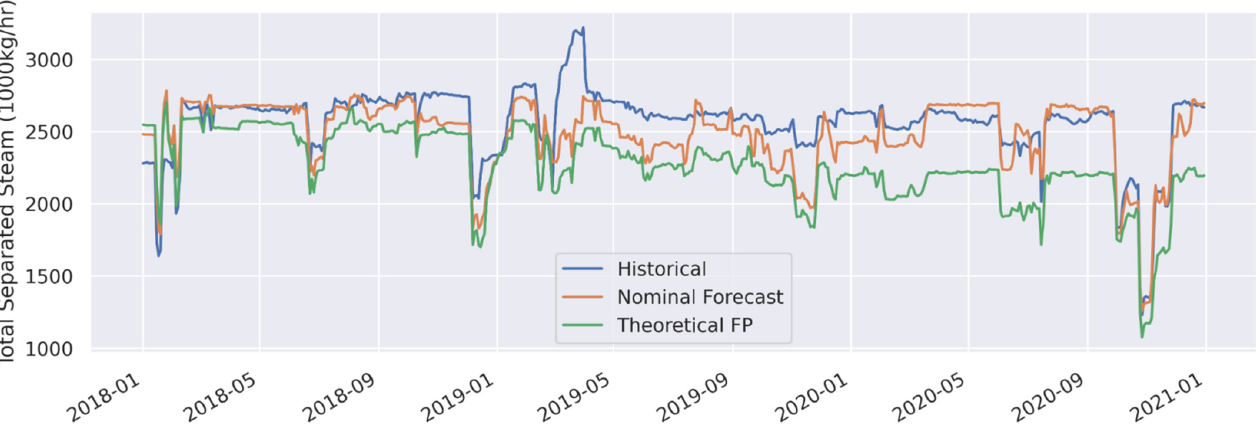
Figure 4. Intermediate pressure ( left ) and low pressure ( right ) separated steam flow to the Wairakei power station, com- paring historically measured data versus the nominal forecast model (including the neural network flash plant model) and the theoretical flash plant forecast (using steam quality at separation pressure as separation efficiency).